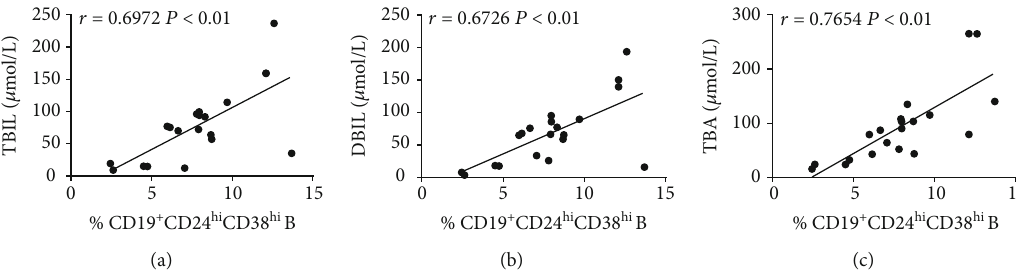
Figure 3: Correlations between CD19 + CD24 hi CD38 hi B cell frequencies and di ff erent laboratory parameters. (a) Signi fi cant positive correlations were found between levels of serum TBIL and the percentage of circulating CD19 + CD24 hi CD38 hi cells in PBC patients. (b) Signi fi cant positive correlations were found between levels of serum DBIL and the percentage of circulating CD19 + CD24 hi CD38 hi cells in PBC patients. (c) Signi fi cant positive correlations were found between levels of serum TBA and the percentage of circulating CD19 + CD24 hi CD38 hi cells in PBC patients; ∗ P < 0 : 05